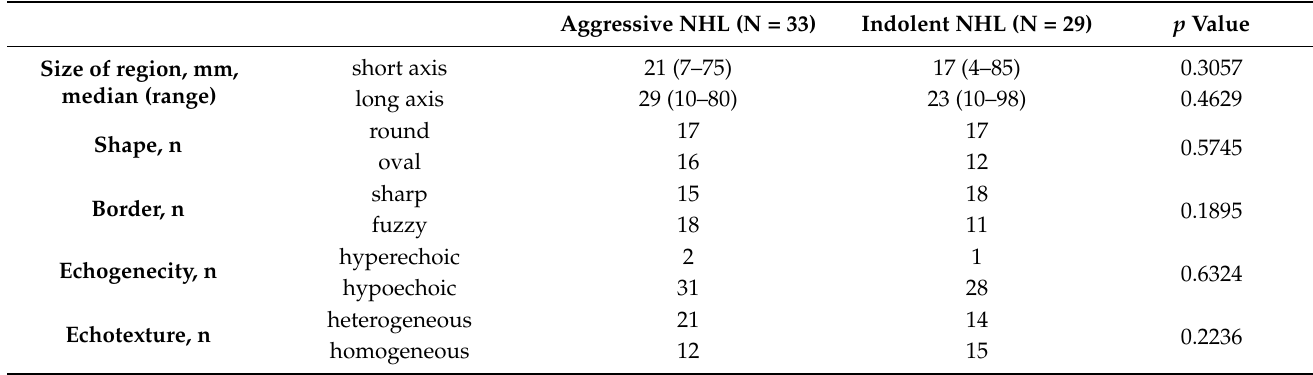
Table 2. The sonographic features of